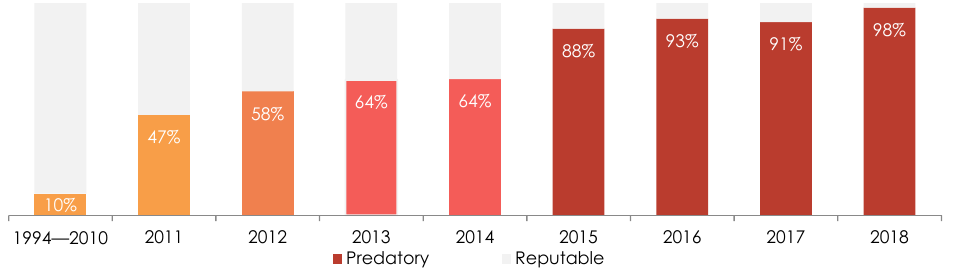
Figure 6. Histogram of number of international articles per author.